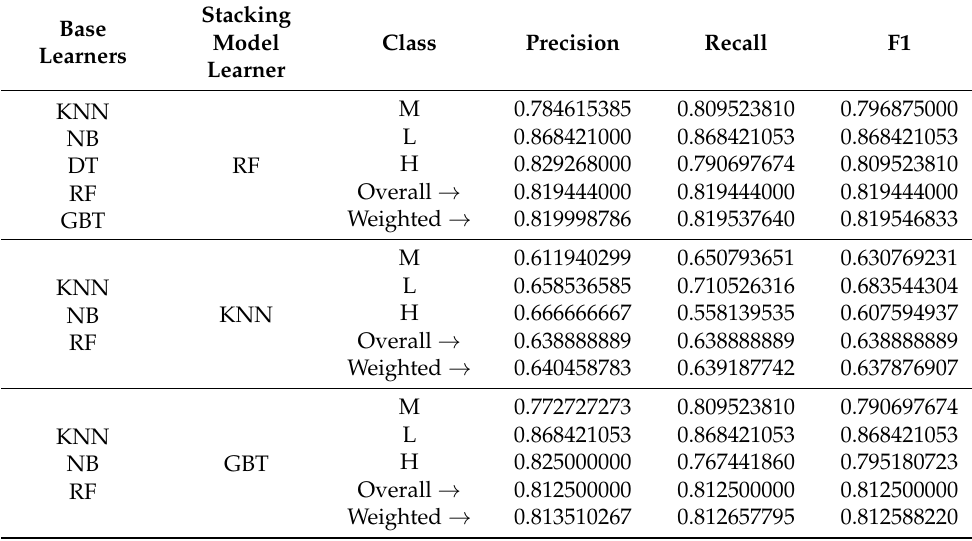
Table 6. Performance metrics for all ML models—with ensemble method III